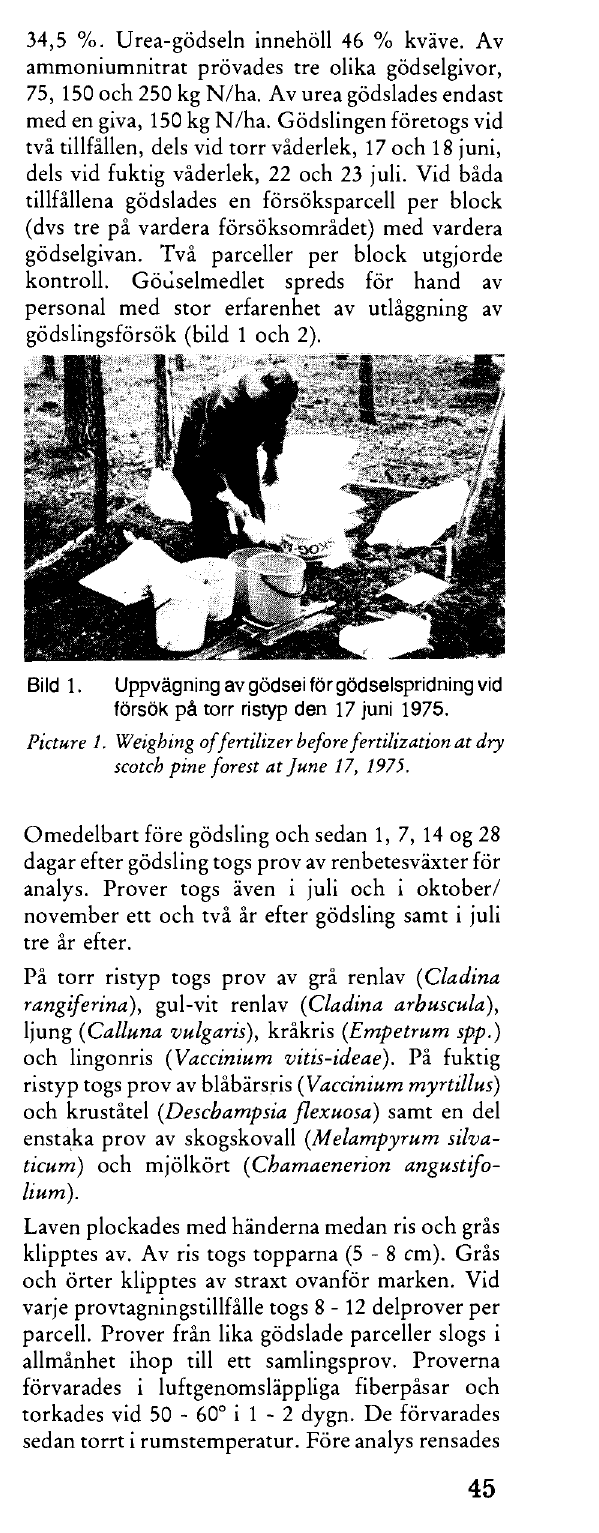
Fig. 1. Försöksparcell på torr ristyp. Fig. 1. Experimental square on dry scotch pine